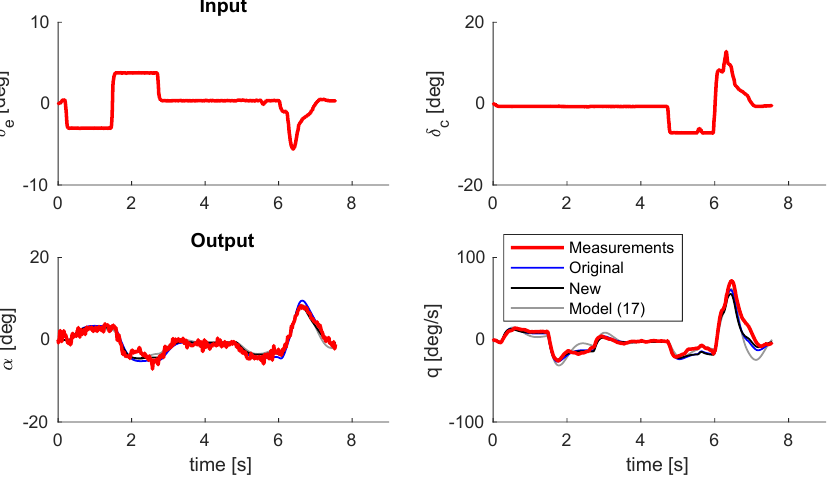
Figure 20. Validation simulations with flight test data in